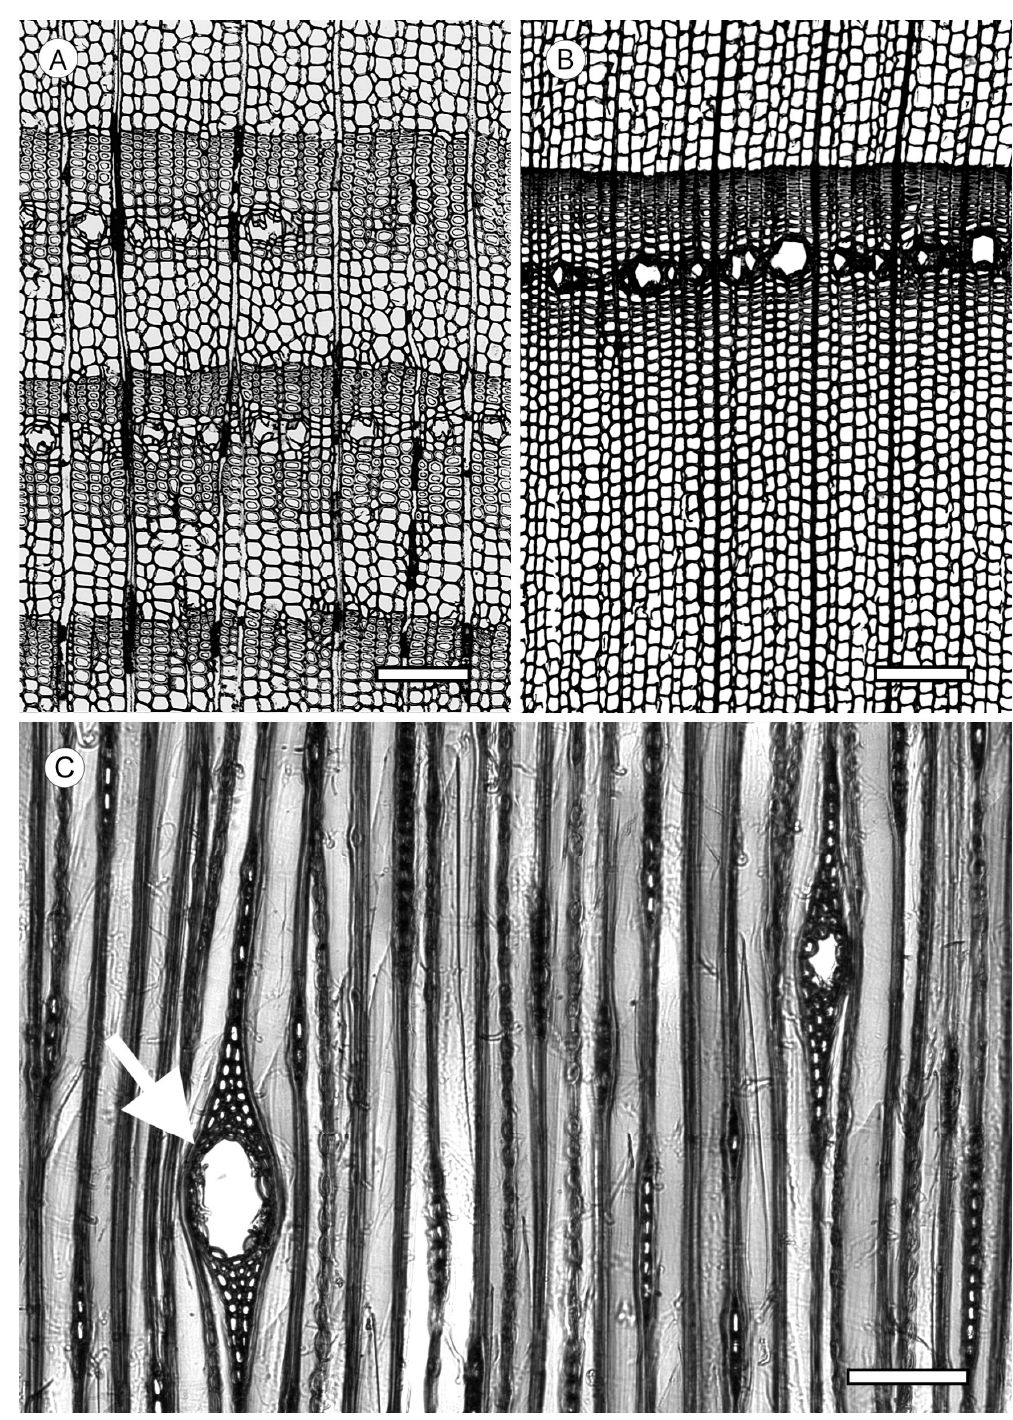
Figure 41. Traumatic axial and radial resin canals. ( A ) Traumatic resin canals in tangential rows in Keteleeria davidiana (C.E.Bertrand) Beissn.; ( B ) Traumatic resin canals in tangential rows in Abies nephrolepis (Trautv.) Maxim.; ( C ) Radial traumatic resin canals in Picea abies (L.) H.Karst. Scale bars. ( A , B ) = 300 μ m; ( C ) = 150 μ m.